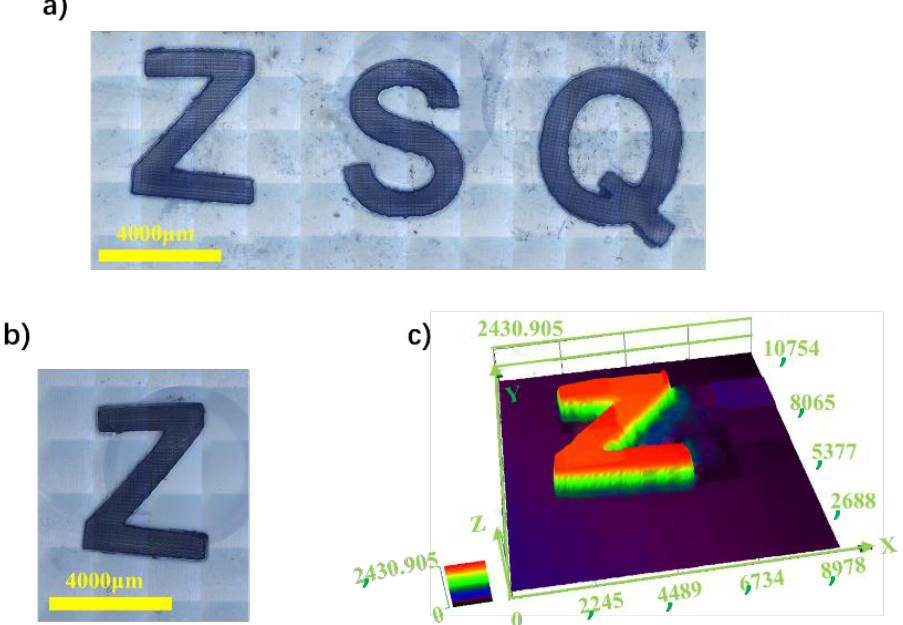
Figure 5. The 3D morphologies of the 3D patterns obtained through the direct laser write experiment initiated with 2wt% [dye-TEA] in PEG-DA aqueous monomer characterized by numerical optical microscope: ( a ) “ZSQ” pattern and ( b , c ) zoom on “Z”